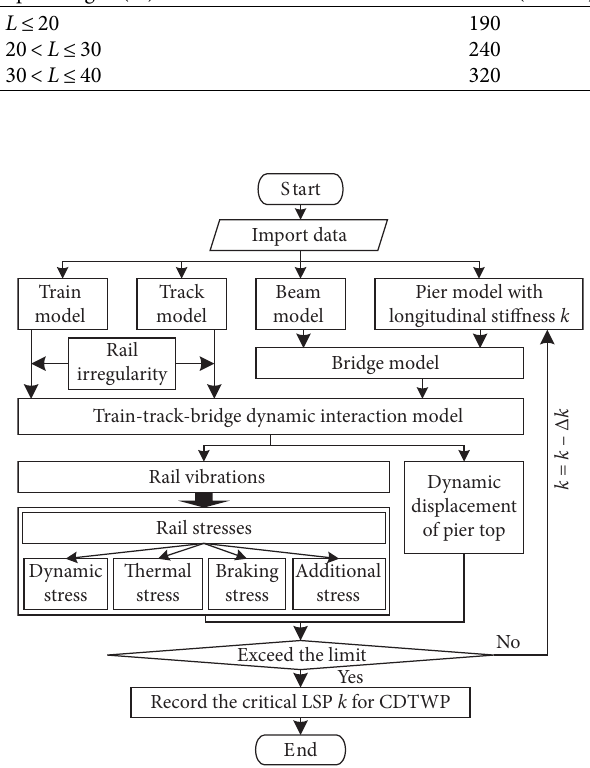
Figure 2: Methodology of determining LSP for